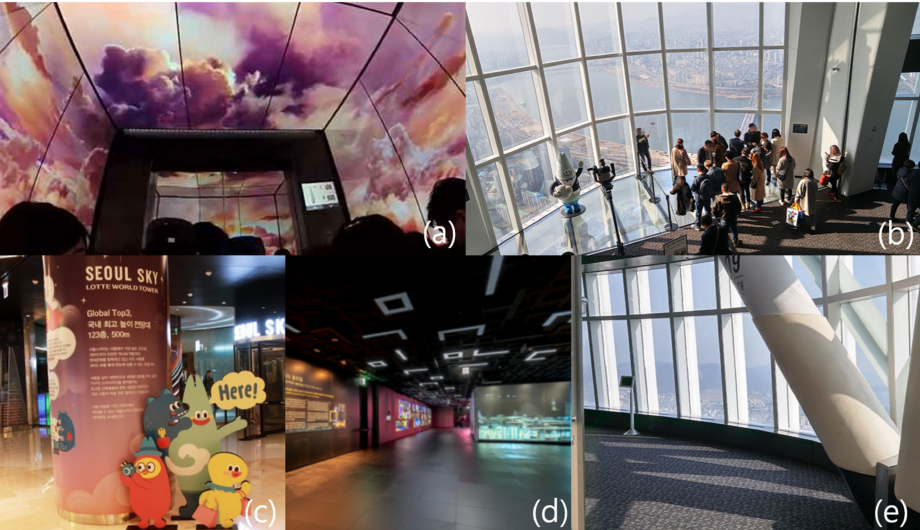
Figure 1. Seoul Sky Observatory: ( a ) Inside the Sky Shuttle Elevator, animations relating to Seoul and the Lotte World Tower are displayed. ( b ) On the Sky Deck on the 118th floor, you can appreciate the height of the observatory by looking through the glass floor. ( c ) At the entrance to Seoul Sky, you can see various Seoul Sky characters: Pix Lolo, Yum Tao, Tower Lota, and Chu Tete (from left). Chu Tete is the character used in the Seoul AR application in this study. ( d ) The platform for the Seoul Sky elevator is connected through spaces with various media displays. ( e ) From the 118th floor of the Seoul Sky Observatory, a 360 ◦ view of the entire landscape of Seoul can be